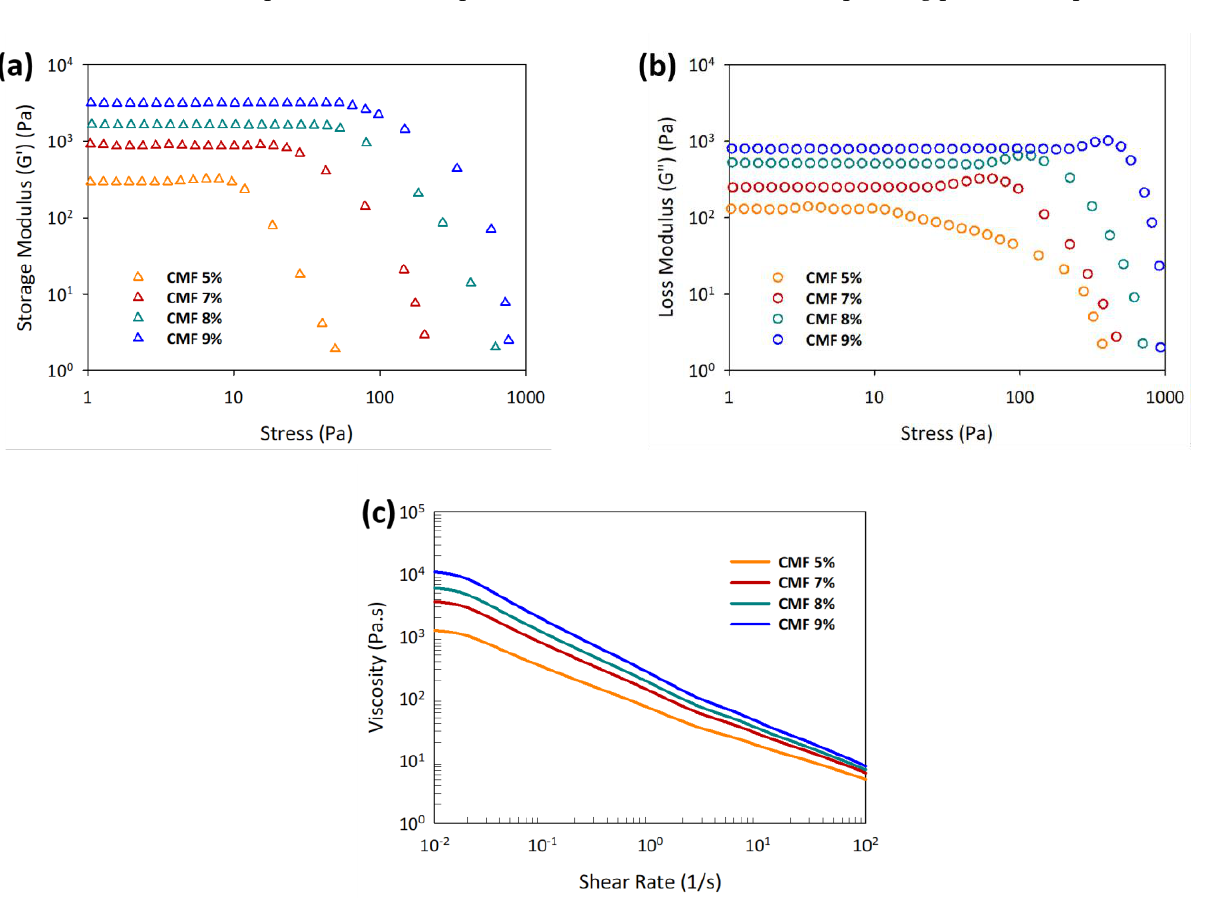
Figure 1. The effect of partially dissolved cellulose on ( a ) storage modulus, ( b ) loss modulus, and ( c ) viscosity at different CMF concentrations.